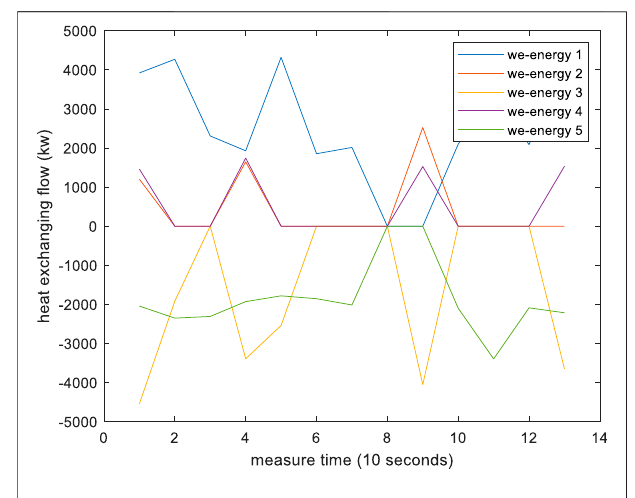
FIGURE 5 | Heat exchanging fl ow